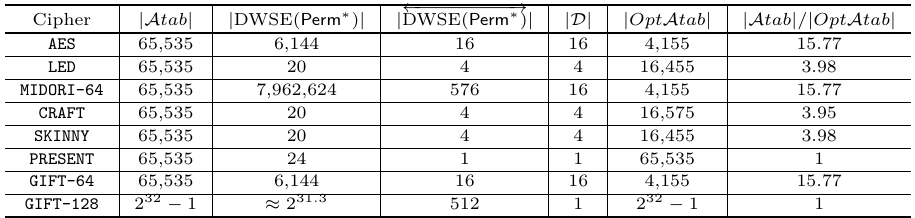
Table 5: Comparisons Between the Sizes of A tab and Opt A